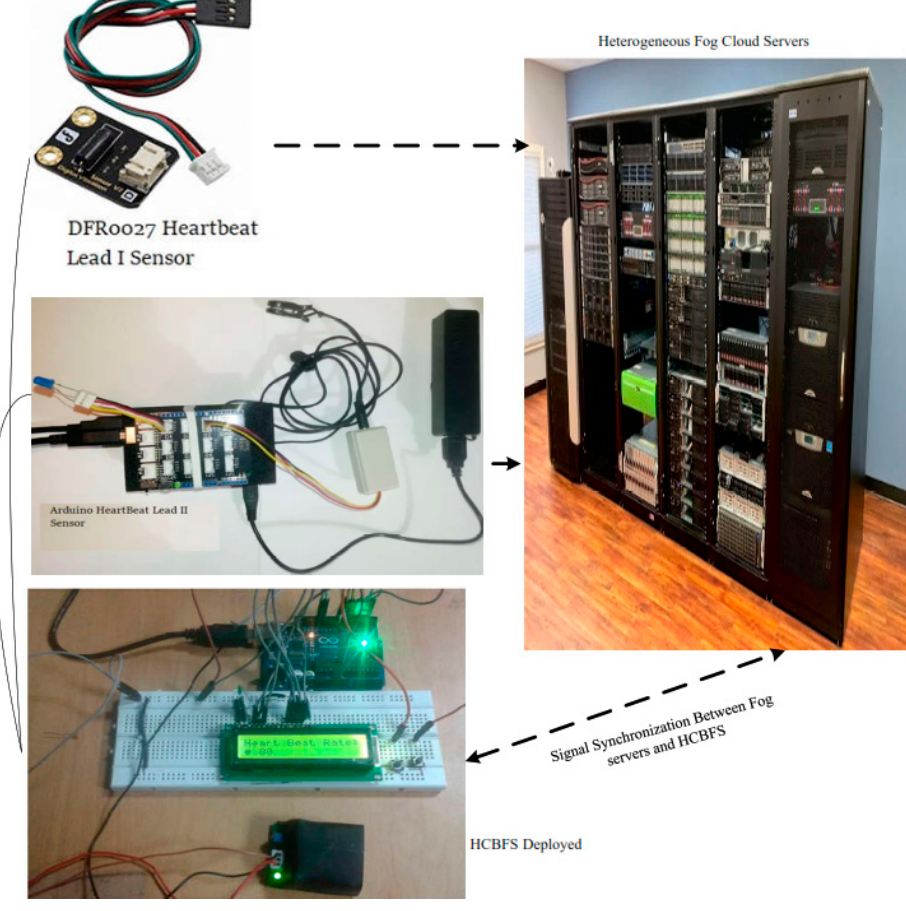
Figure 5. Health care based fog cloud system. Table 2. Simulation